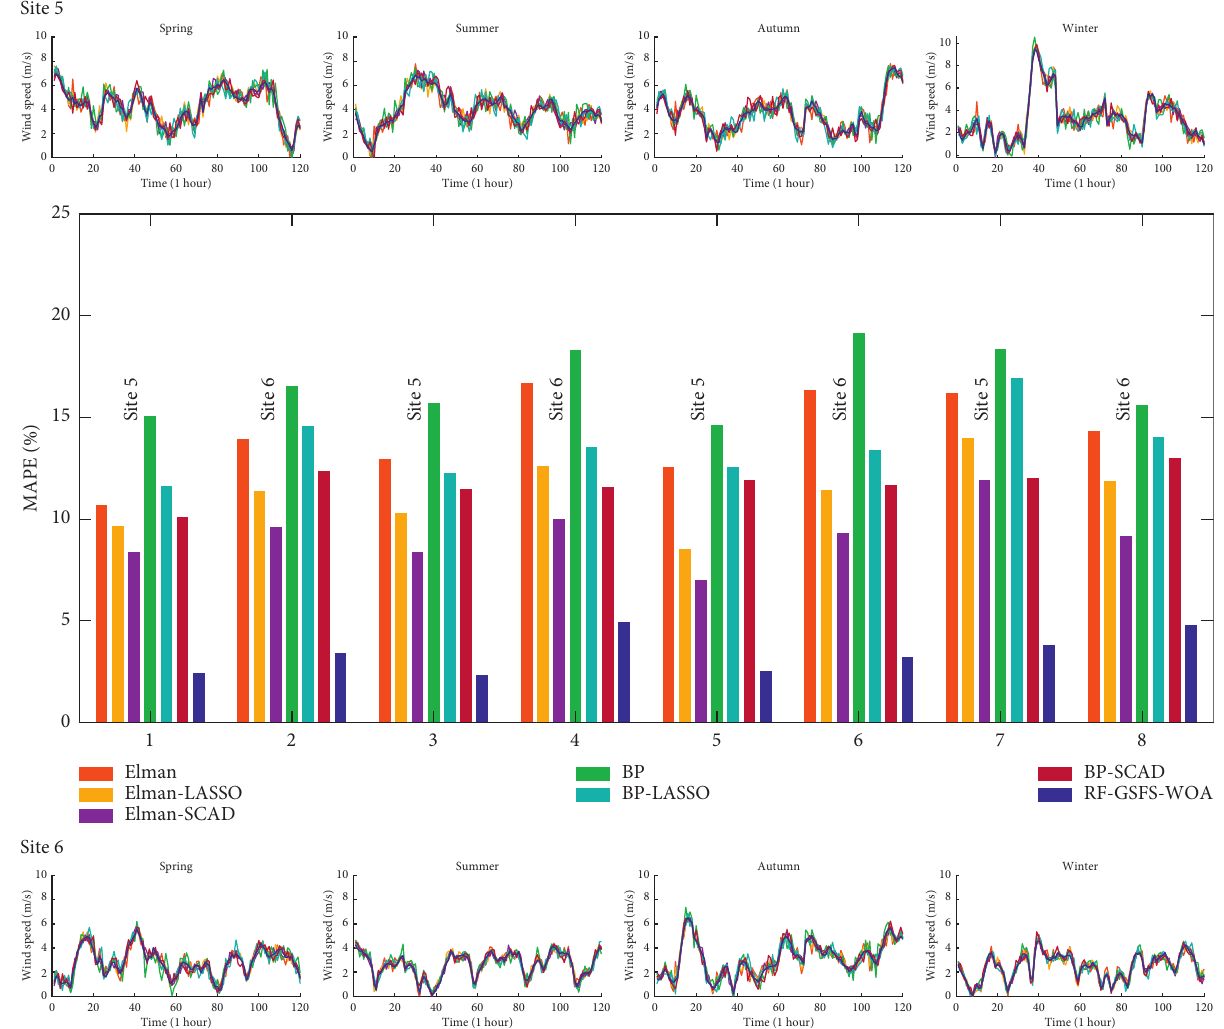
Figure 7: Forecasting results of seven models at Site 5 and Site 6.